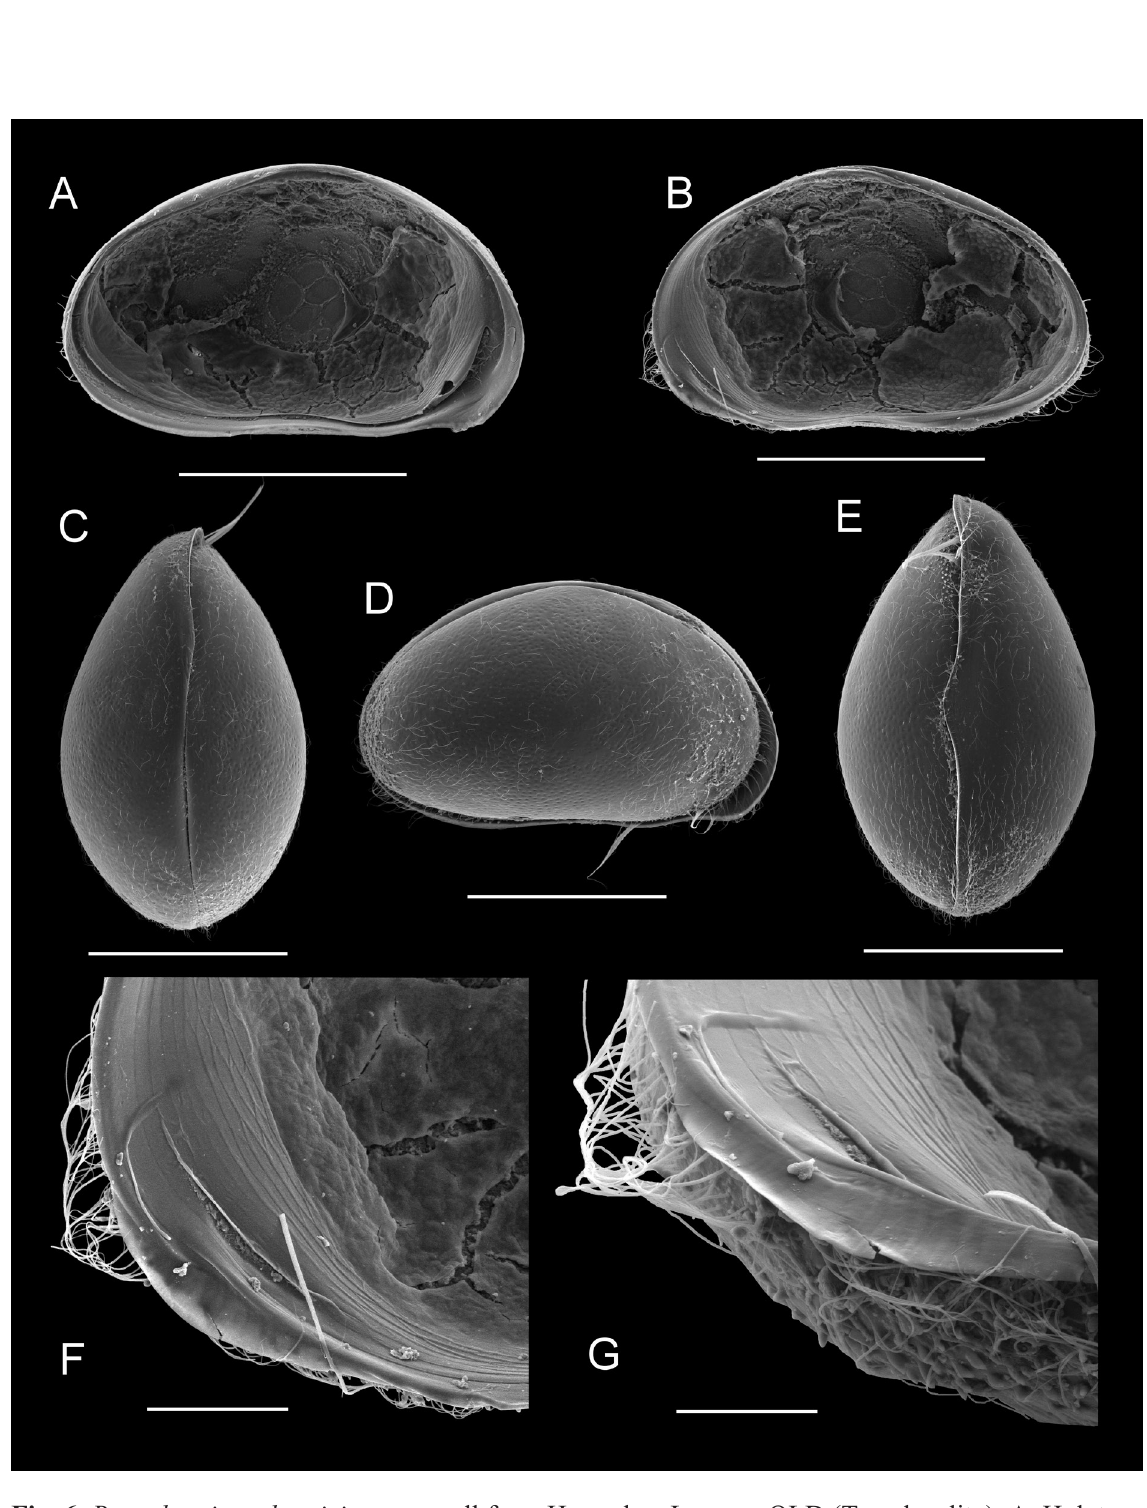
Fig. 6. Bennelongia mckenziei sp. nov., all from Horseshoe Lagoon, QLD (Type locality). A . Holotype ♀, LVi (W40071). B . Holotype ♀, RVi (W40071). C . ♀, Cp dorsal (W40072). D . ♀, CpRl (W40073). E . Holotype ♀, Cp ventral (W40071). F . Holotype ♀, RVi detail anteriorly (W40071). G . Holotype ♀, RVi detail anteriorly (W40071). Scales: A-E = 500 μm, F-G = 100